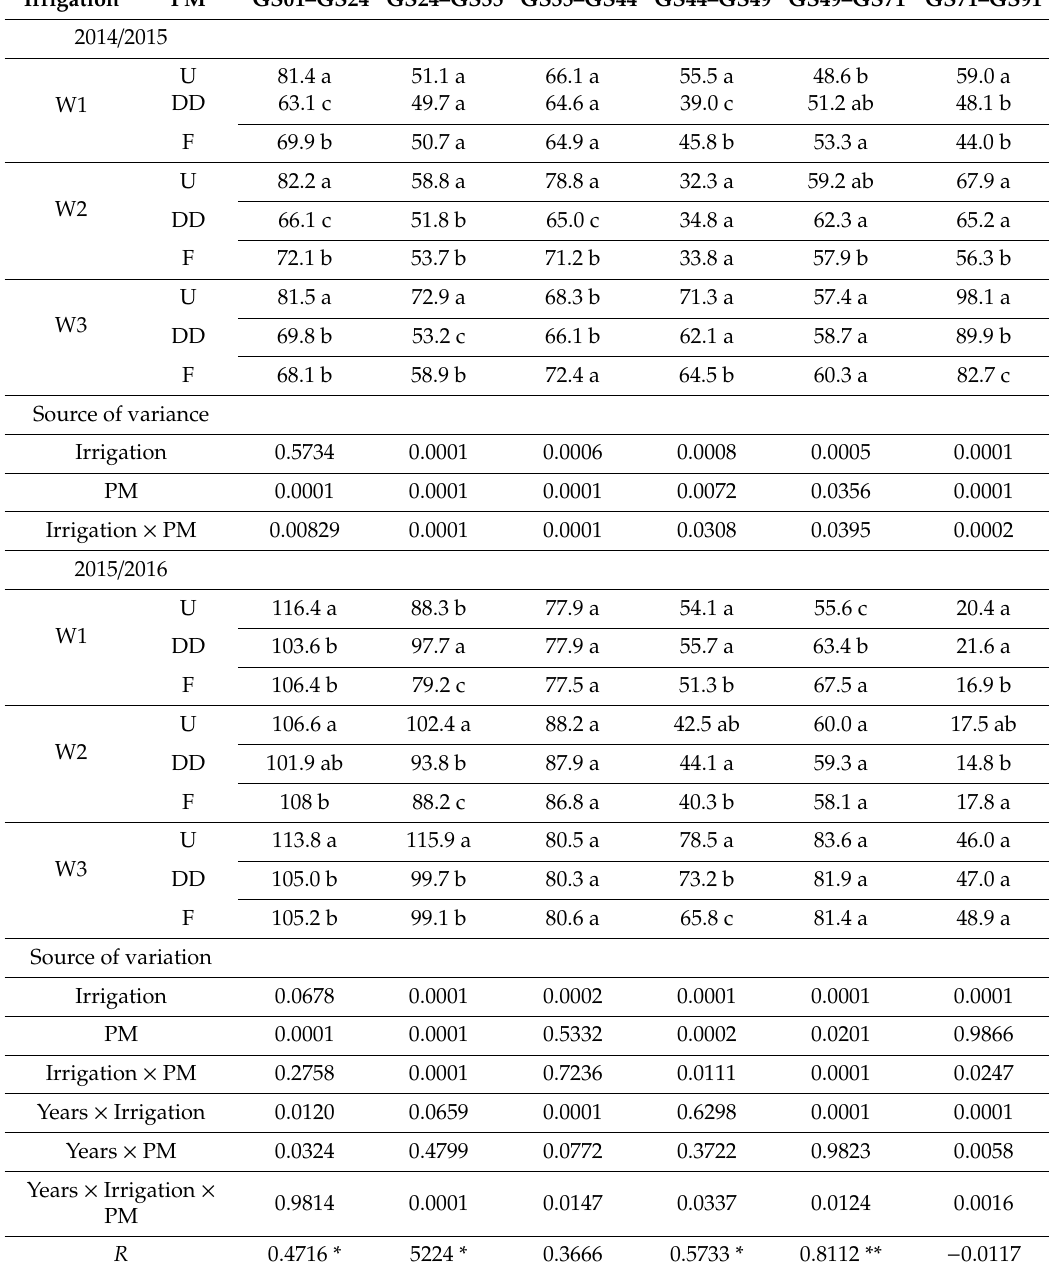
Table 5. E ff ects of planting mode (PM) and irrigation on the evapotranspiration (mm) at di ff erent stages of winter wheat growth in